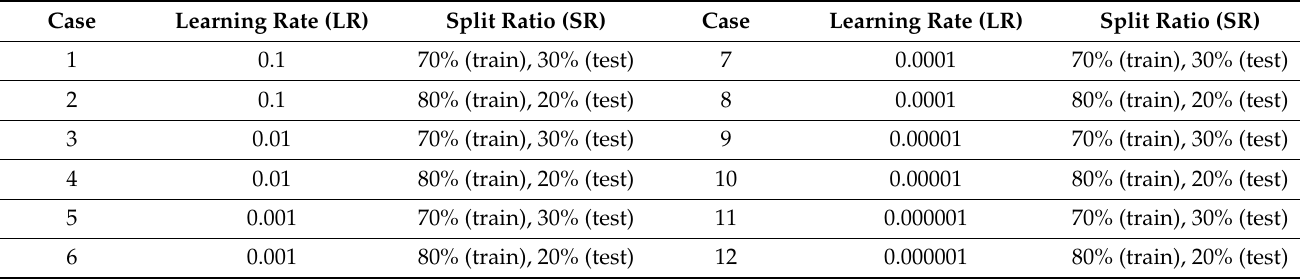
Table 6. List of 12 different cases of learning rates and split ratios to define the suitable values of the proposed